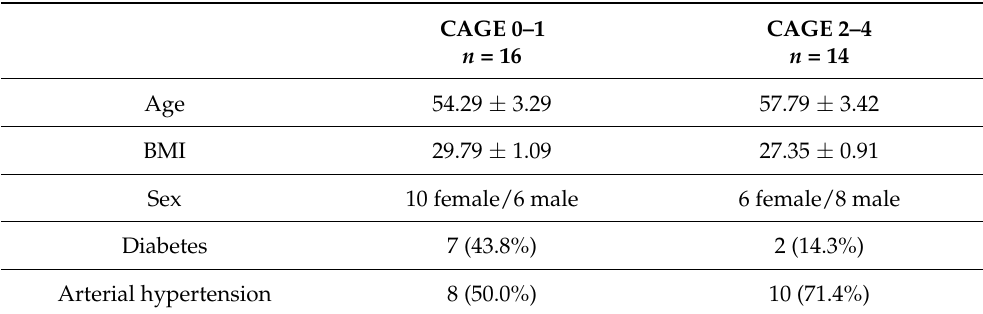
Table 2. Comparison based on the CAGE questionnaire comparing CAGE 0–1 point (no risk for alcoholism) versus CAGE 2–4 points (risk for